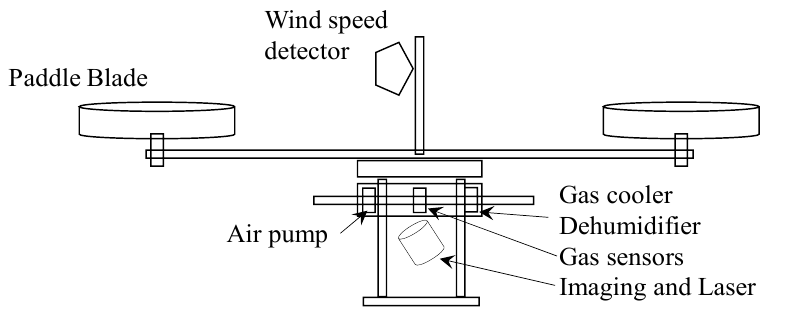
Figure 4. A drone with modules for emission detection.